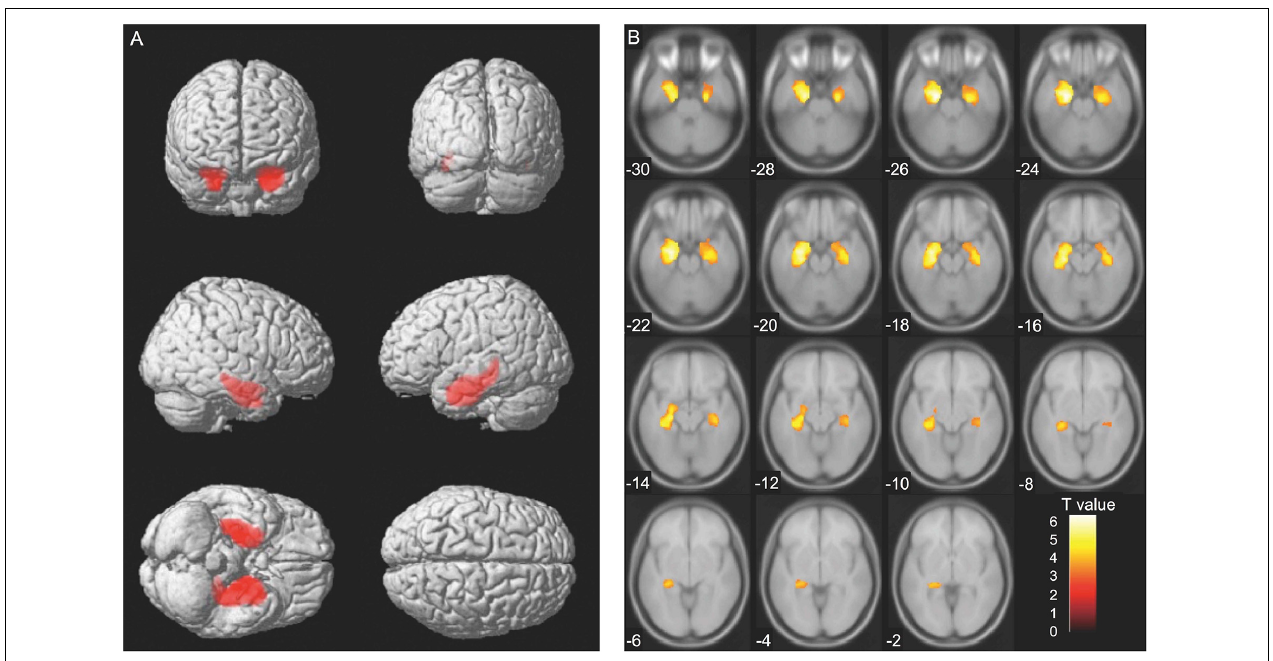
FIGURE 3 | Voxel-based morphometry findings: Association between changes in clinical dementia rating (CDR) scores and brain volume (Time 2). Association between higher CDR scores and decreased brain volume (Time 2) evaluated using multiple regression analysis. The thresholds for statistics were set to T = 3.22 for the height threshold and k = 2684 voxels for the extent threshold. Significant clusters containing the left and the right hippocampus are shown in (A) whole brain images and (B) axial images. The T -value applies to (B) axial